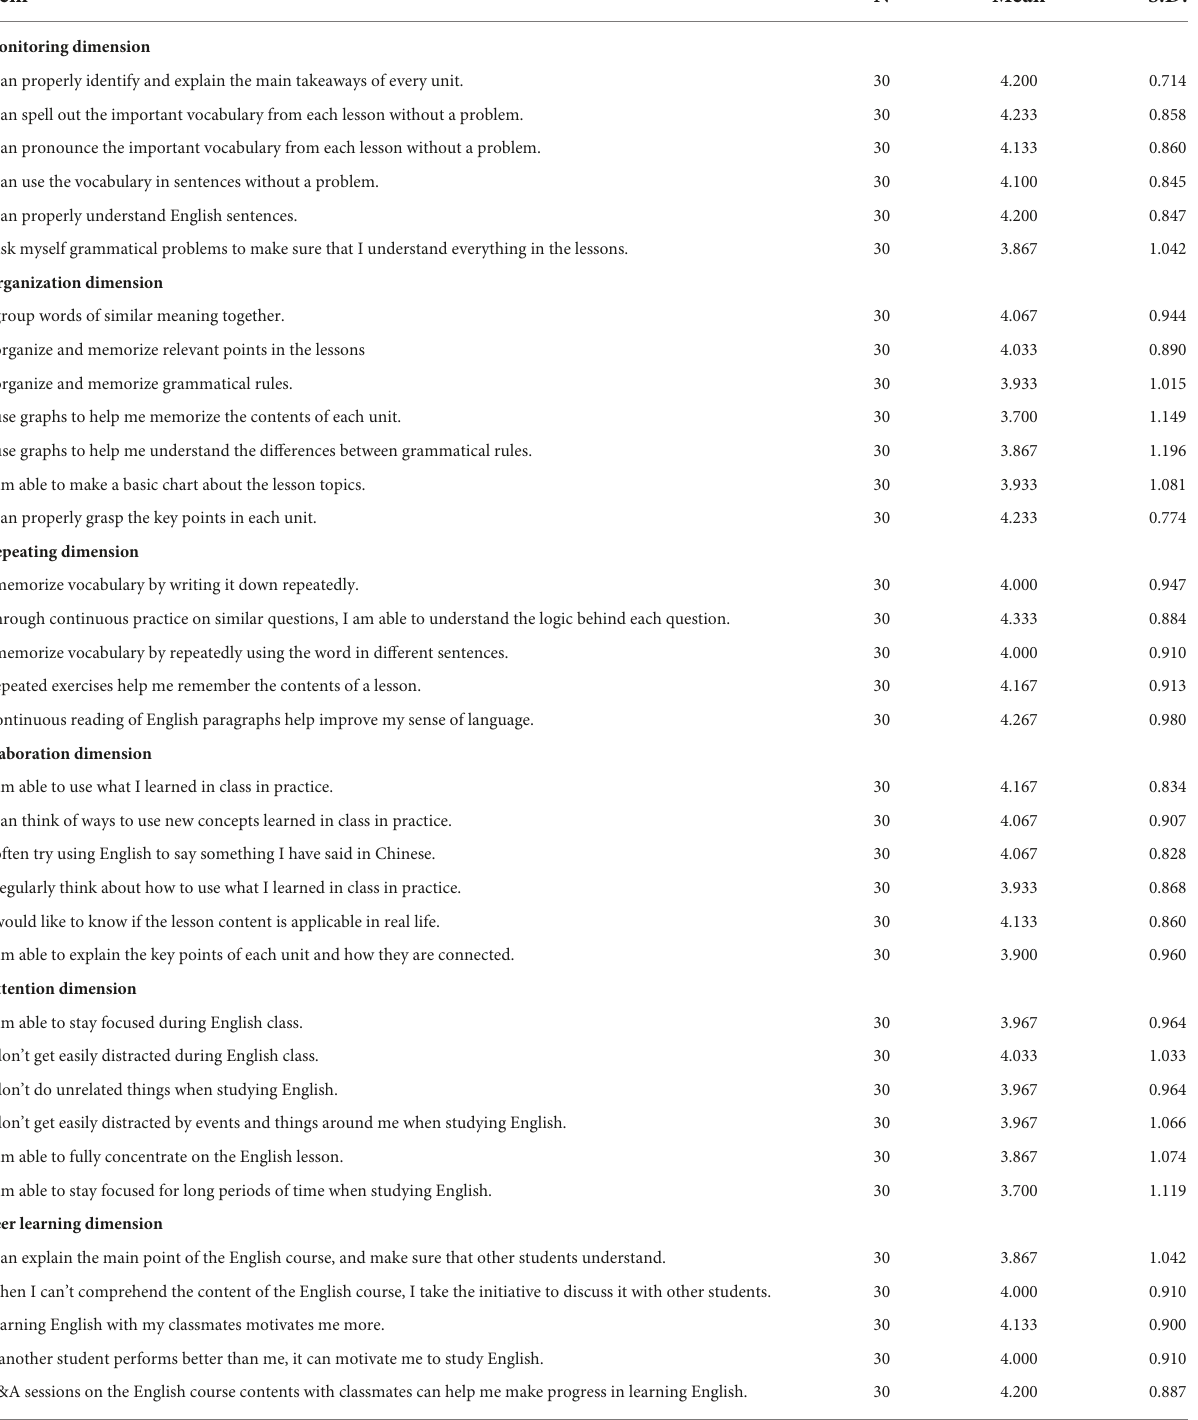
TABLE 1 Results of the STEAM learning perceptions questionnaire.